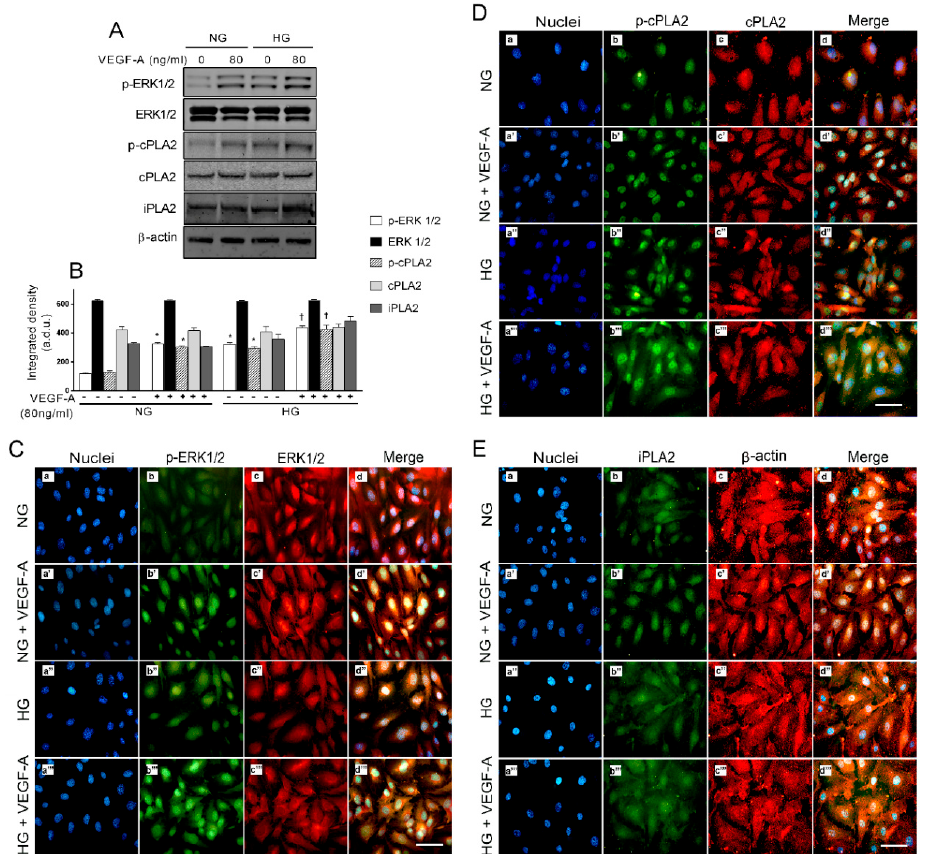
Figure 5. Exogenous VEGF-A exacerbated high glucose (HG)-induced activation of ERK / PLA2 axis in human retinal endothelial cells (HRECs). Panel ( A ): immunoblot analysis of HREC whole-cell lysates, using antibodies against phospho-ERK1 / 2 (p-ERK1 / 2), total ERK1 / 2, phospho-cPLA2 (p-cPLA2), total cPLA2 and iPLA2. The blot was probed with anti β -actin antibody to verify equal loading of 30 µ g proteins per lane. Panel ( B ): densitometric analysis of immunoblot indicating protein quantification of each band (in arbitrary densitometry unit, a.d.u.), carried out with the Image J program. Panel ( C ): immunocytochemical staining for p-ERK 1 / 2 (green fluorescence) and ERK 1 / 2 (red fluorescence) in HRECs grown in normal glucose (NG, 5 mM; a, b, c, d), in normal glucose plus 80 ng / mL of VEGF-A (a’, b’, c’, d’), in high glucose (HG, 25 mM; a”, b”, c”, d”) or in high glucose supplemented with 80 ng / mL of VEGF-A (HG + VEGF-A; a”’, b”’, c”’, d”’). Blue fluorescence indicates DAPI staining of cell nuclei. Merged pictures are shown in the fourth column (d, d’, d”, and d”’). In control HRECs, green fluorescence was almost undetectable, either in the cytoplasm or in the nucleus. HG-culture conditions induced an increase in green fluorescence (indicating p-ERK1 / 2 activation), particularly in the nuclear region (b”’ vs. b’ and b” vs. b, respectively). Panel ( D ): immunocytochemical staining for p-cPLA2 (green fluorescence) and cPLA2 (red fluorescence) in HRECs grown in normal glucose (NG, 5 mM; a, b, c, d), in normal glucose plus 80 ng / mL of VEGF-A (a’, b’, c’, d’), in high glucose (HG, 25 mM; a”, b”, c”, d”) or in HG supplemented with 80 ng / mL of VEGF-A (HG + VEGF-A; a”’, b”’, c”’, d”’). Blue fluorescence indicates DAPI staining of cell nuclei. Merged pictures are shown in the fourth column (d, d’, d”, and d”’). In control HRECs, green fluorescence is detectable only at nuclear level; an increase (indicating cPLA2 activation) can be observed in both cytoplasm and nuclei in HG-culture conditions, (b”’ vs. b’ and b” vs. b, respectively). Panel ( E ): immunocytochemical staining for iPLA2 (green fluorescence) and β -actin (red fluorescence) in HRECs grown in normal glucose (NG, 5 mM; a, b, c, d), in normal glucose plus 80 ng / mL of VEGF-A (a’, b’, c’, d’), in high glucose (HG, 25 mM; a”, b”, c”, d”) or in high glucose supplemented with 80 ng / mL of VEGF-A (HG + VEGF-A; a”’, b”’, c”’, d”’). Blue fluorescence indicates DAPI staining of cell nuclei. Merged pictures are shown in the fourth column (d, d’, d”, and d”’). Immunostaining for iPLA2 is increased in HRECs cultured in high glucose supplemented with 80 ng / mL of VEGF-A (b”’ vs. b”, b’, and b). Magnification: × 40; scale bars: 100 µ